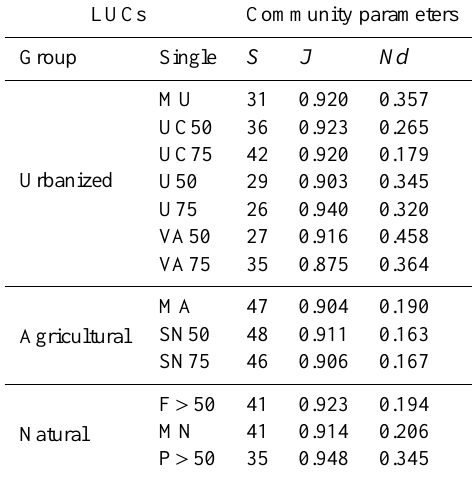
Table 8. Structural parameters of bird communities inside 13 se- lected land use categories (LUCs). See Table 1 for land use codes and groups. Community parameter abbreviations: S = species rich- ness; J = Evenness; Nd = dominant